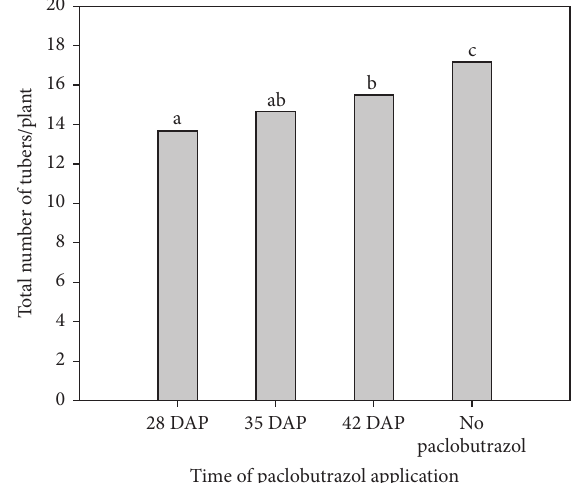
Figure1:Effectoftimeofpaclobutrazolapplicationontotalnumber of potato tubers per plant.